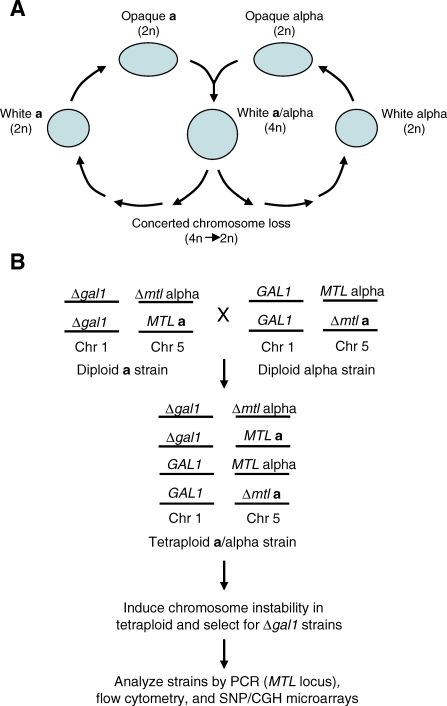
Analysis of the Parasexual Mating Cycle in C. albicans
(A) Overview of the mating cycle in C. albicans. White MTLa and MTLα cells must switch to the opaque state to undergo mating and formation of a mononuclear tetraploid a/α cell. A reduction in ploidy back to the diploid (or near diploid) can occur by random chromosome loss.(B) A scheme for selection of diploid progeny strains from tetraploids. A tetraploid strain, RBY18, heterozygous for the GAL1 gene on Chromosome (Chr) 1 and for all four MTL alleles on Chr 5 was constructed by mating MTLa and MTLα diploid strains, as shown. After induction of chromosome instability, strains that had undergone a reduction in ploidy were selected for by growth on 2-deoxygalactose (2-DOG) medium, as only strains that have lost the GAL1 gene are able to grow on medium containing 2-DOG. Progeny strains were subsequently analyzed by PCR of the MTL locus and by flow cytometric analysis to confirm they were diploid strains. Strains were then analyzed by SNP and CGH microarrays to determine their genetic content.